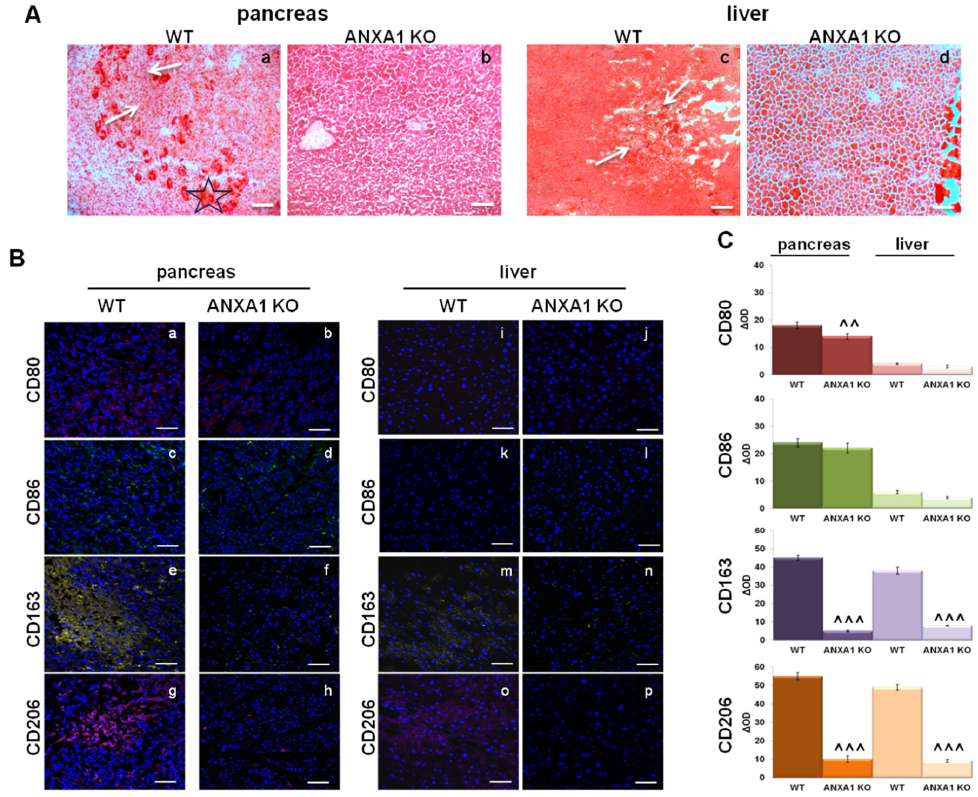
Figure 6. Macrophage infiltration in SCID mice sections derived from primary pancreatic tumors and livers after intrapancreatic implantation of WT and ANXA1 KO MIA PaCa-2 cells. In detail, we indicated as WT and ANXA1 KO pancreas the sections derived from mice in whose pancreas we have previously implanted WT and ANXA1 KO MIA PaCa-2 cells, respectively, and in which primary tumors have been developed. Additionally, WT and ANXA1 KO livers represented the hepatic sections in which we had found significantly more metastatic lesions deriving from tumors originating from WT MIA PaCa-2 cells compared to ANXA1 KO ones. ( A ) Pancreas (panels a and b) and liver (panels c and d) sections have been stained by H&E. Infiltrating ductal-like structures were labeled by star; macrophage infiltrations were marked by white arrows. Bar = 100 µ m. ( B ) Representative images of CD80 (panels a and b; i and j), CD86 (panels c and d; k and l) (M1 macrophage markers) and CD163 (panels e and f; m and n) and CD206 (panels g and h; o and p) (M2 macrophage markers) staining by immunofluorescence in WT and ANXA1 KO mice pancreas and liver (livers in which we have found metastatic lesions derived from intrapancreatic injection of WT MIA PaCa-2 cells) sections. ( C ) The histograms showed the densitometry analysis on immunofluorescence images based on the intensity of each signal compared to the total number of nuclei. Nuclei were stained with DAPI 1:1000 for 30 min at room temperature (RT) in the dark. Magnification 40 × 1.4 NA. Bar = 100 µ m. Data represent the mean of three independent experiments ± standard deviation with similar results. ˆˆ p < 0.01; ˆˆˆ p < 0.001 for ANXA1 KO vs. WT cells